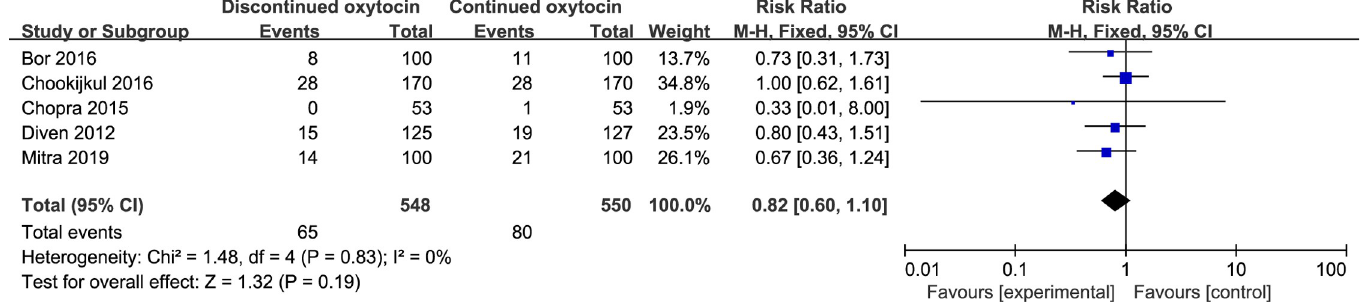
Fig 6. Pooled results for each